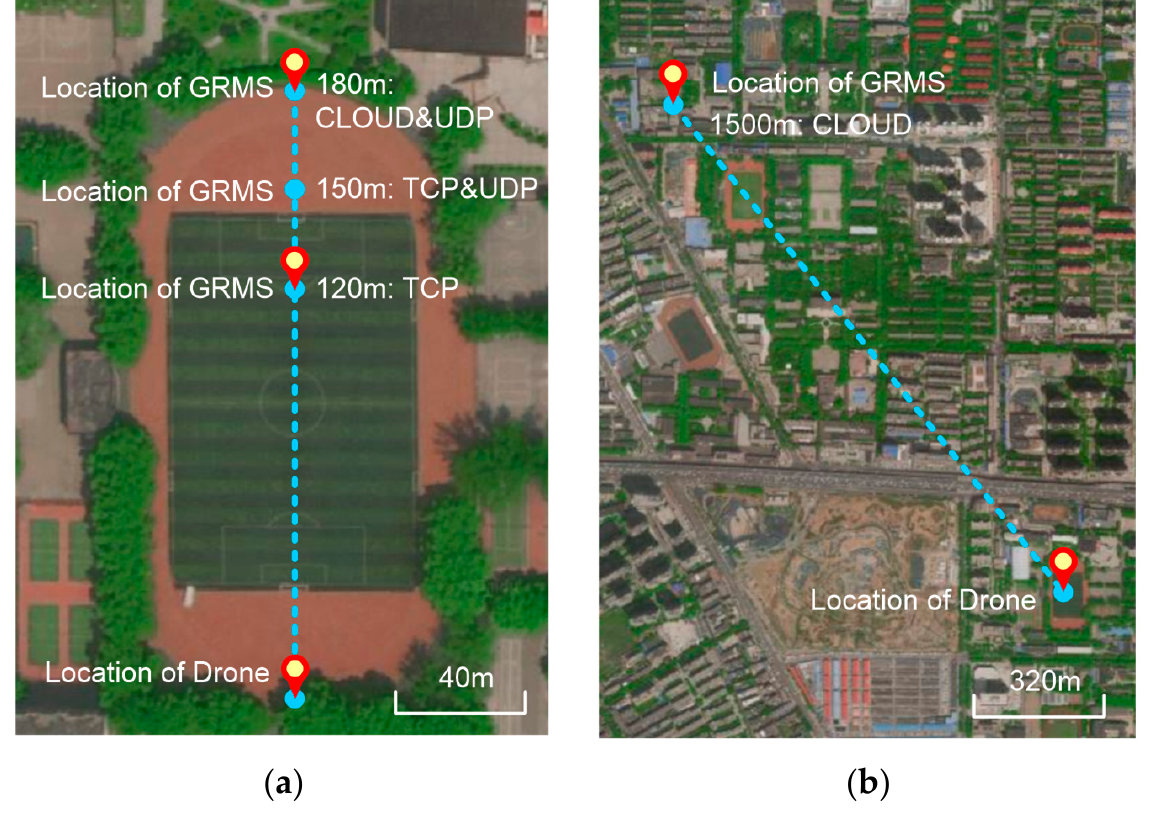
Figure 10. Four distance settings for communication performance test: ( a ) 120 m, 150 m, and 180 m; ( b ) 1500 m.